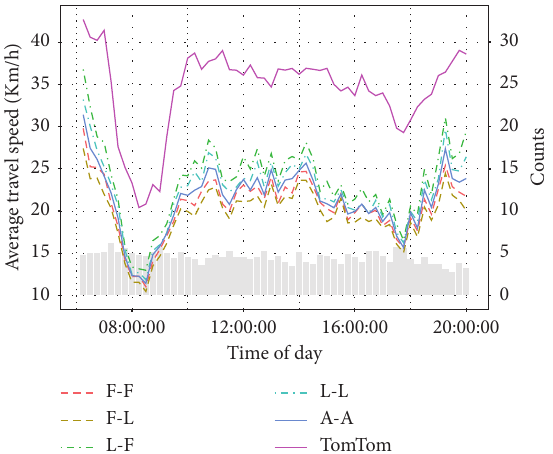
Figure 14: The comparison of five BTaverage speeds and TomTom average speed of link 48-154.